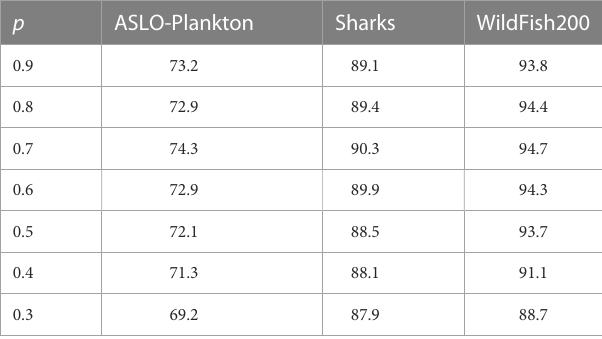
TABLE 3 Ablative experiments on applying TSSA to different layers.